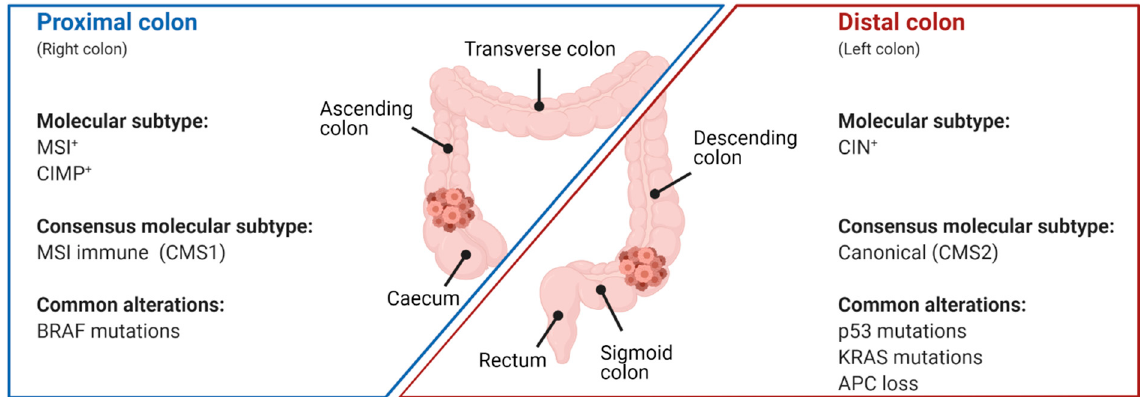
Figure 3. Associations of molecular features with the anatomical location of CRC. Simplified schematic representation of the proximal (caecum, ascending colon, and transverse colon) and distal colon (descending colon; sigmoid colon). Tumors in the proximal colon are associated with microsatellite instability (MSI), CpG island methylator phenotype (CIMP), the consensus molecular subtype (CMS; CMS1), and mutations in BRAF. CRCs of the distal colon are characterized by chromosomal instability (CIN) and CMS2, and often display mutations in p53, KRAS, and APC.